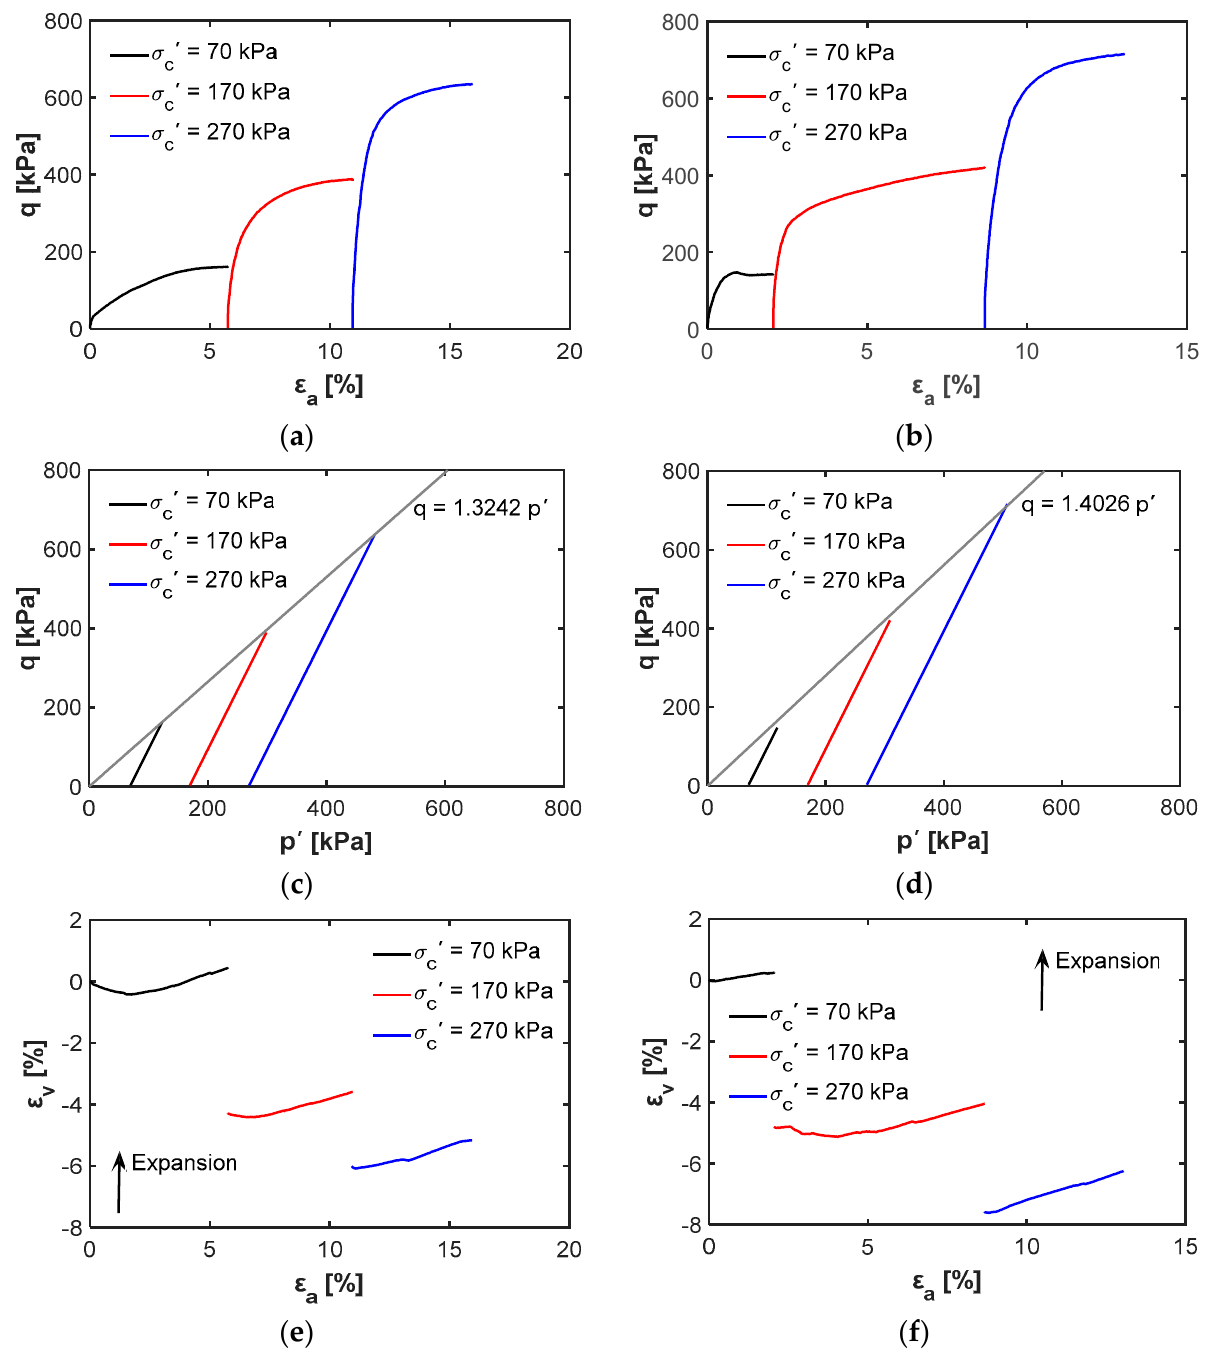
Figure 12. Shearing phase plots at T = 60 °C of: ( a , c , e ) oM; ( b , d , f ) mM. Table 2. Variations of the measured values of slope M of the p ′ – q diagrams at failure. Temperature (°C)